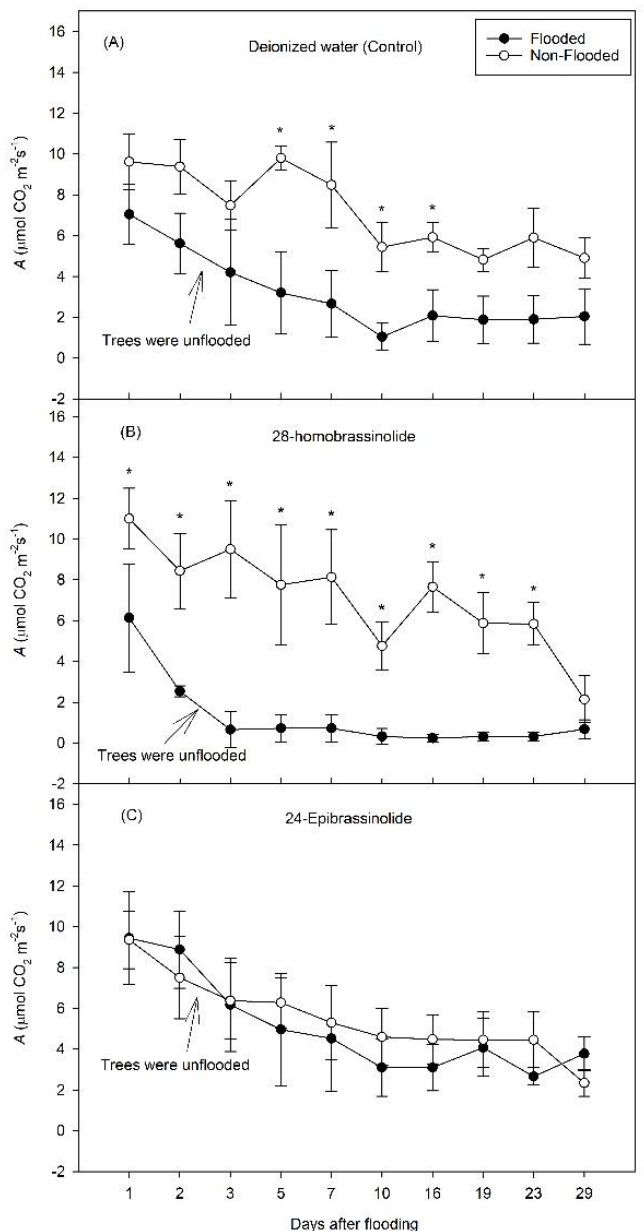
Figure 1. Effect of flooding on net CO 2 assimilation ( A ) of ‘Monroe’ avocado trees treated with ( A ) deionized water as a control, ( B ) 28-homobrassinolide, or ( C ) 24-epibrassinolide and flooded or nonflooded (Experiment 1). Symbols and bars indicate means ± std. err. Significant differences ( p ≤ 0.05) between flooding treatments are indicated with an asterisk and were determined by repeated-measures ANOVA. ‘Trees were unflooded’ indicates the day on which trees were removed from the flooding treatment to start the recovery